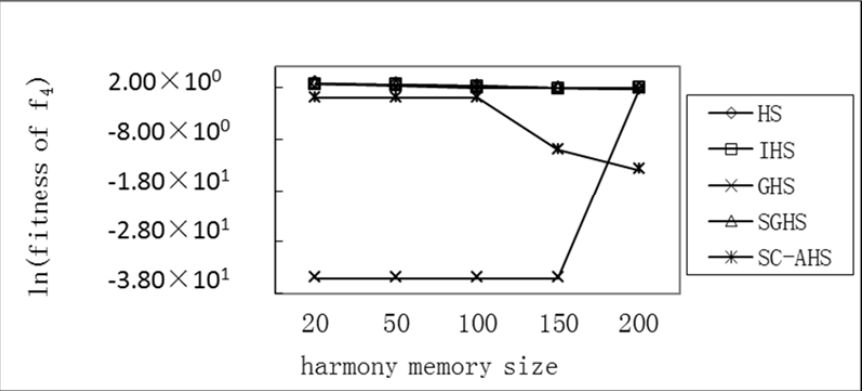
Figure 10. Comparison of the average optimum with different harmony memory sizes of the Ackley function.